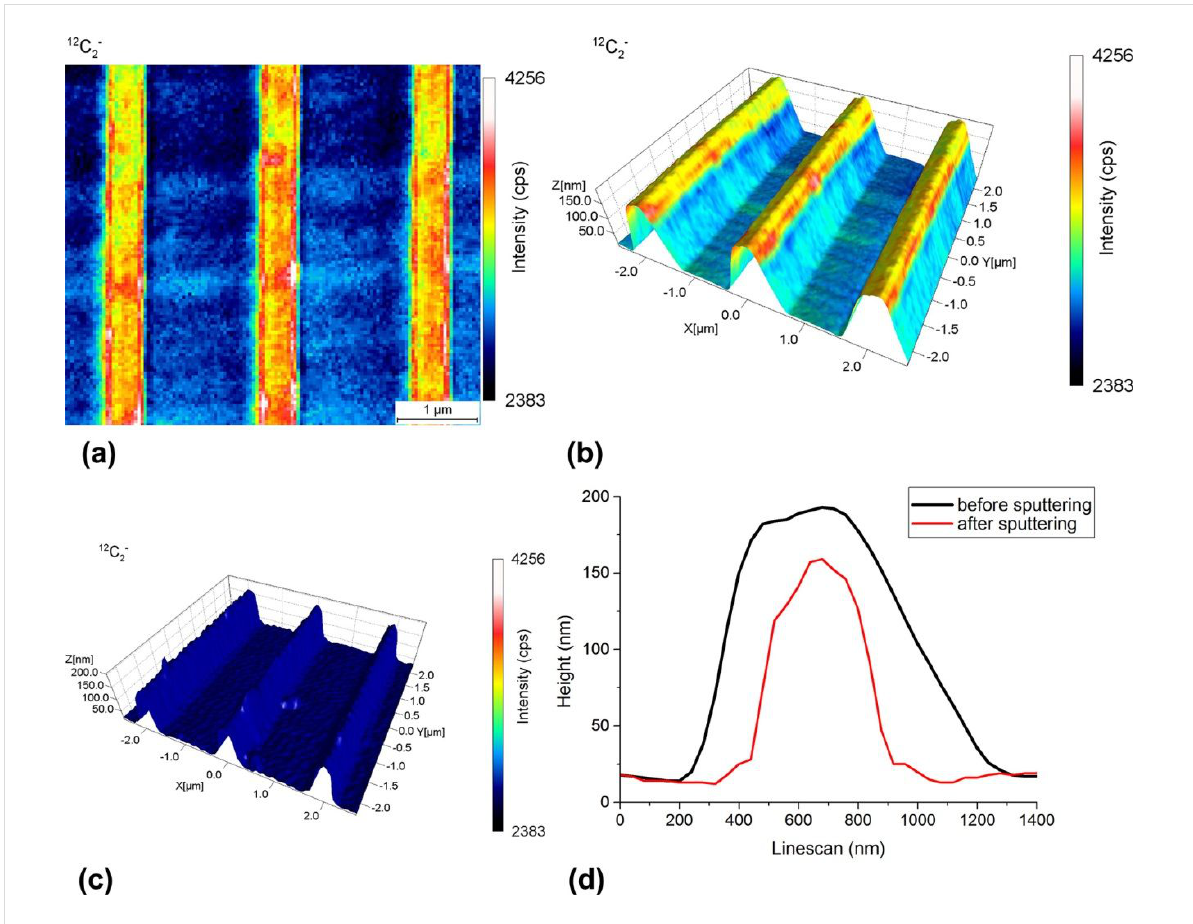
Figure 4: Chemical image showing the 12 C 2 − secondary ion intensity recorded from the TaN reticule with a 10 nm carbon capping layer (a). 3D SIMS–SPM reconstruction combining the chemical information as well as the topographical information after a dose of 2.4 × 10 16 ions/cm 2 (b) and after a dose of 1.2 × 10 17 ions/cm 2 (c). AFM profiles before sputtering and after sputtering with a dose of 1.2 × 10 17 ions/cm 2 . As the trench was sputtered as well, it was preferred to plot the trench surface before and after sputtering to the same height. In this way, the change of the ridge shape is shown more clearly